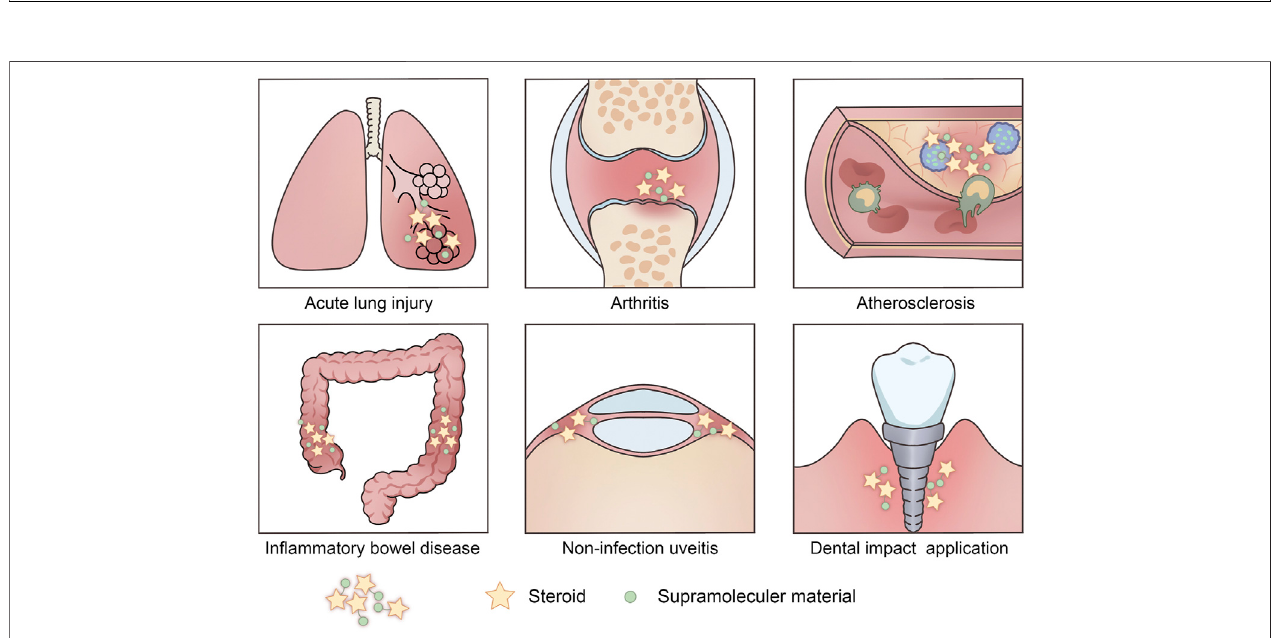
FIGURE 2 | The biomedical applications of the glucocorticoid drug delivery systems. Glucocorticoid drugs based supramolecular systems have been widely used in acute lung injury, arthritis, atherosclerosis, in fl ammatory bowel disease, non-infection uveitis, and dental impact application.